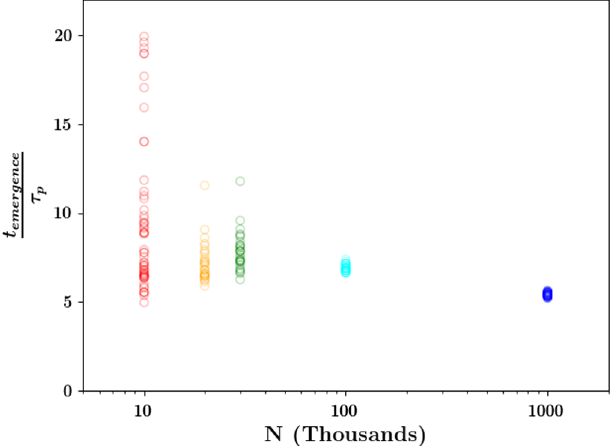
FIG. 4. The emergence time divided by the plasma period as a function of the number of electrons in the initial Gaussian profile with σ r ≈ 100 μ m and σ z ≈ 0 . 4 μ m. Emergence time was deter- mined as the first time the density away from the inner-most- value exceeded the inner-most-value by 2%. Notice that the emergence time converges to about 5 τ p for high densities, but at low densities the emergence time has high variability with a median shifted to higher multiples of the plasma